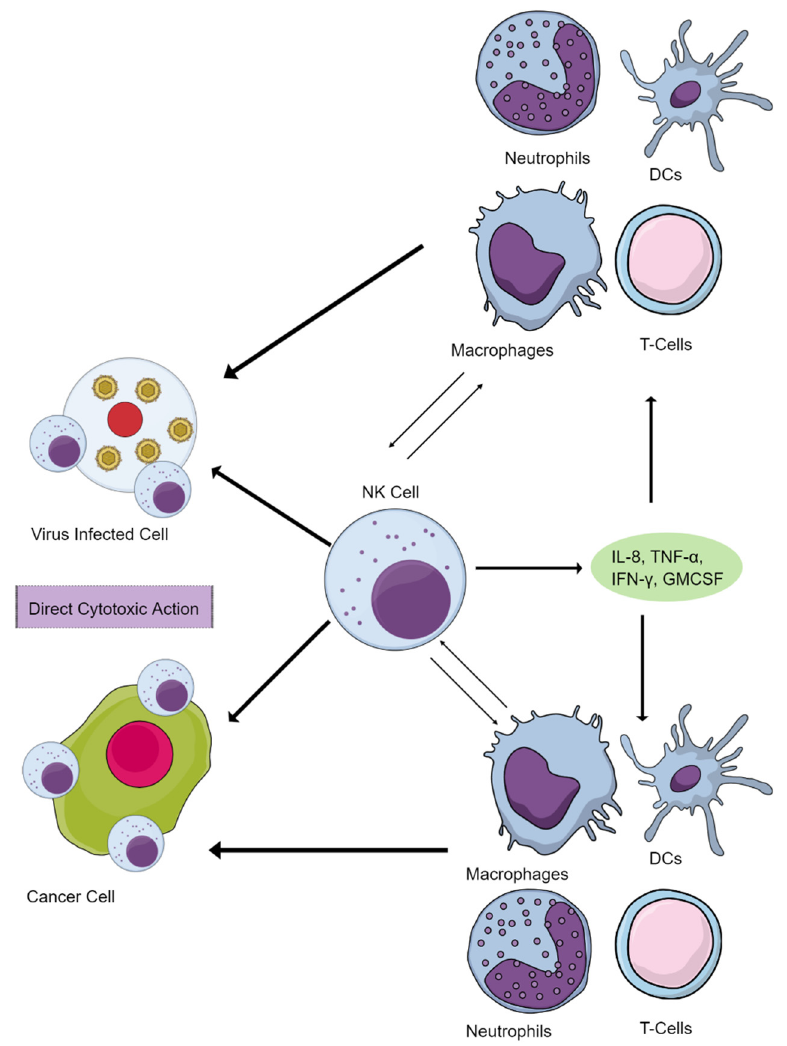
Figure 1. Diagrammatic representation of NK cells in immunoregulation during virus infections and cancer. NK cells are crucial to maintaining immune homeostasis due to their key role in cytokine and chemokine production. Cytokines and chemokines can interact with immune cells to induce a proinflammatory response, thus protecting the host.